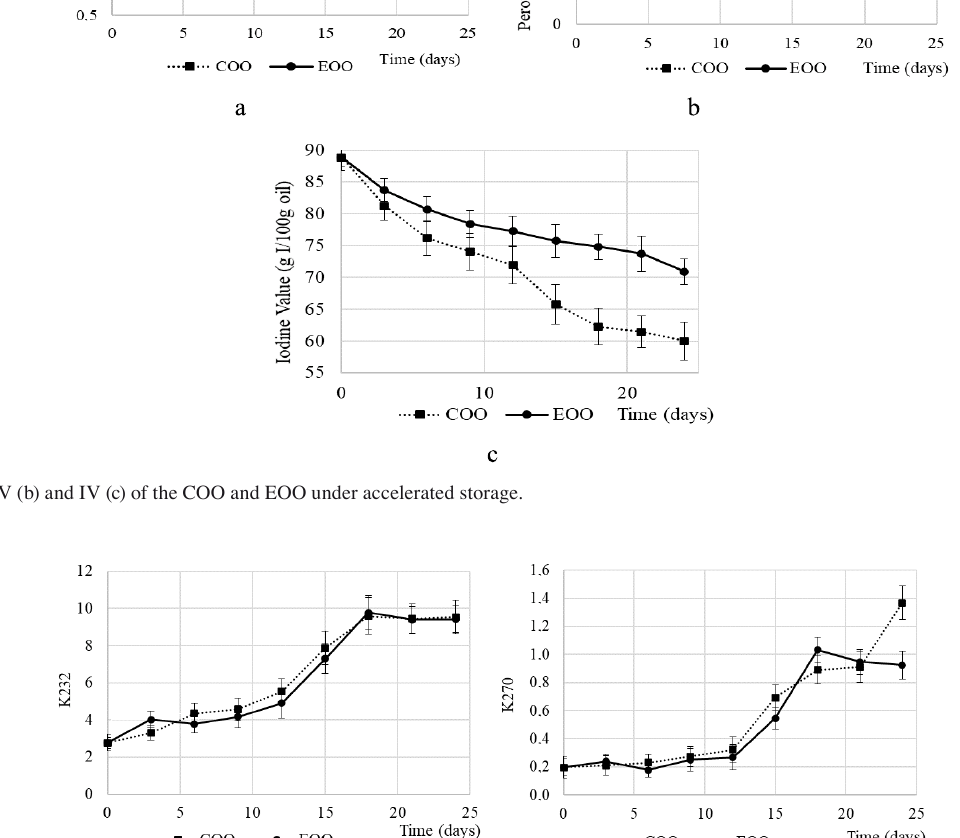
dation ( r analli et al., 2006). It has been reported that the addition of olive leaves during the olive oil extraction process can improve the quality of the oil ( M alheiro et al., 2013; h annachi and e lFalleh , 2020 ). Polyphenols extracted from olive leaves have been used to in-